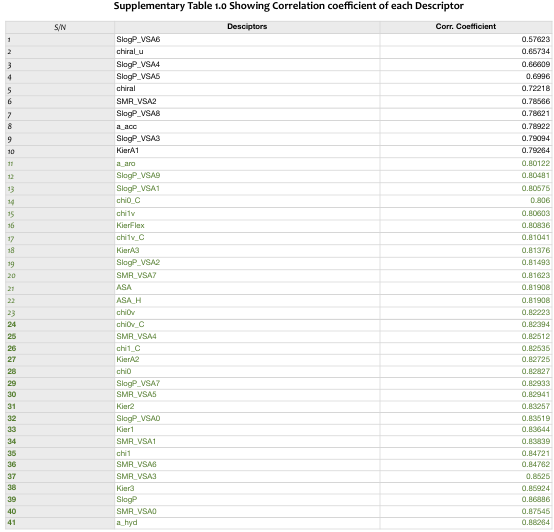
Scatter plot of the experimental pIC 50 vs. pIC 50 - predictions of Eq.(10) (blue) and Eq.